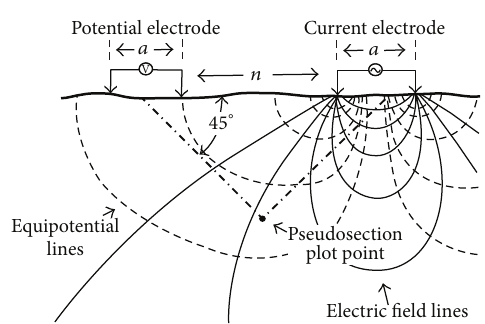
Figure 1: Research area.